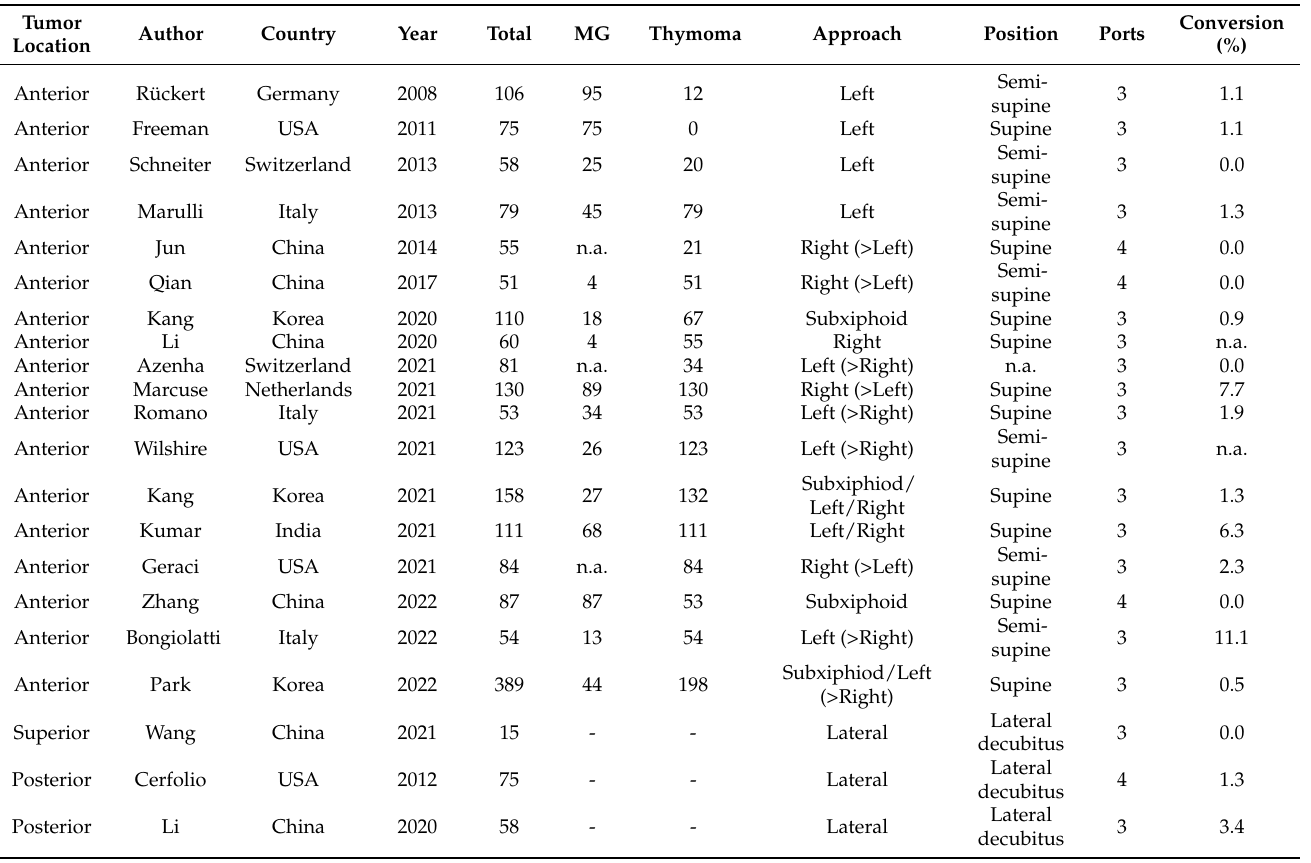
Table 2. Literature summary of robotic mediastinal tumor resections including large case series and descriptions of